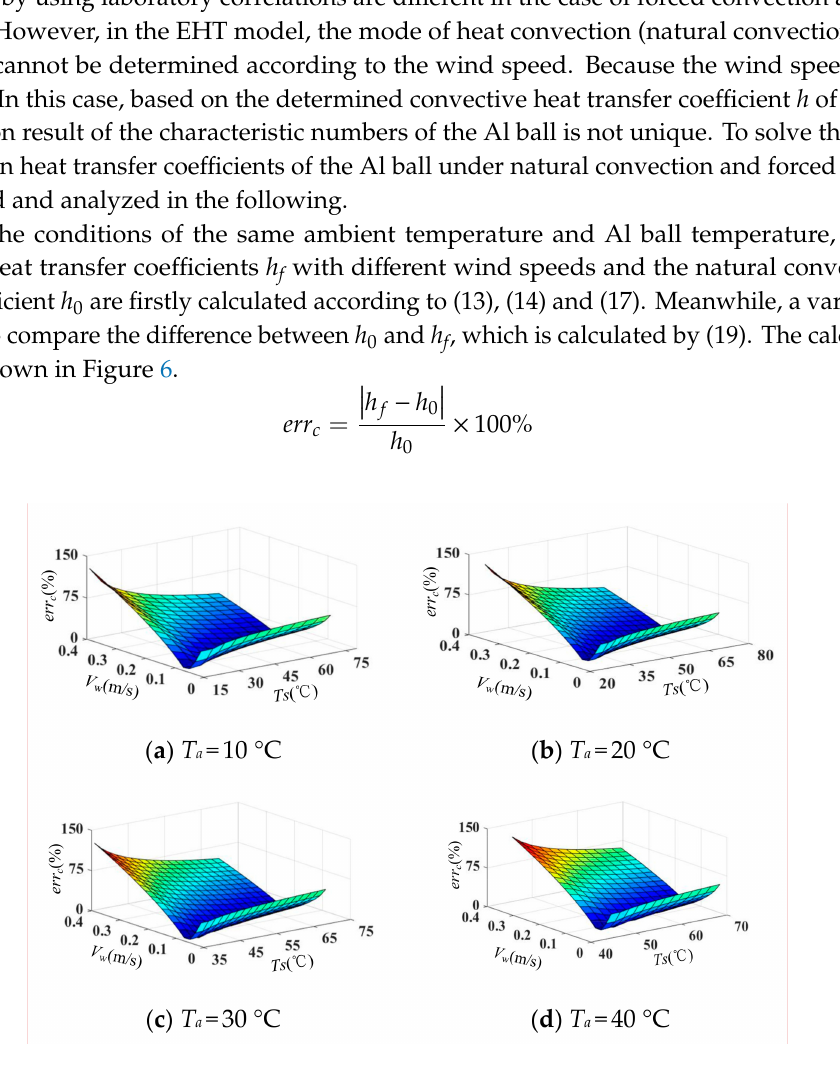
Figure 6. err c results under di ff erent wind speeds and Al ball